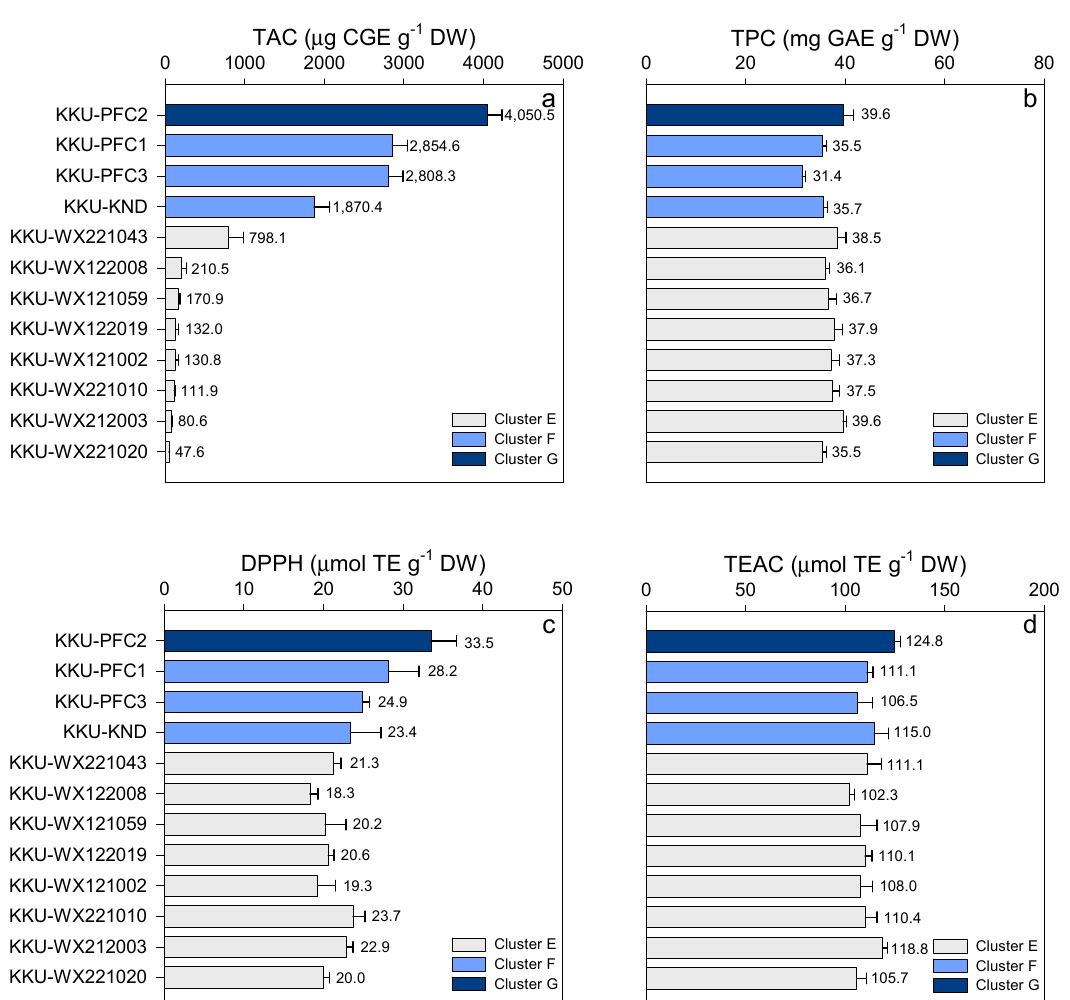
Figure 3. Means for ( a ) the total anthocyanin content, ( b ) total phenolic content, ( c ) DPPH radical scavenging activity and ( d ) Trolox equivalent antioxidant capacity in the tassel of the highest waxy corn genotypes (cluster E, F and G) evaluated across two seasons. Data are expressed as the mean ± SD.